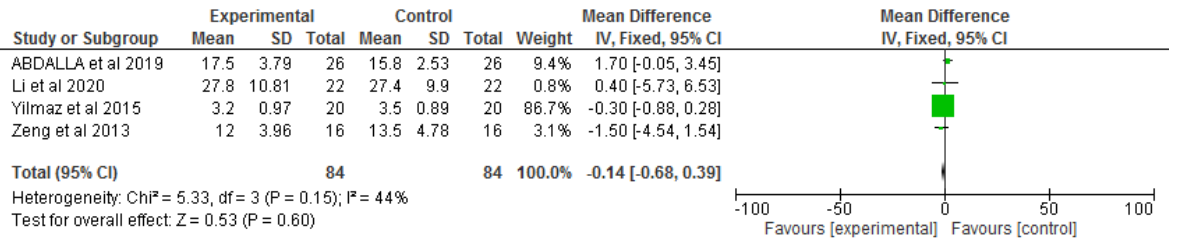
Figure 17. Funnel plot for maxillary expansion between experiment and control after removing the studies lies outside the funnel. 4. Discussion Respiratory function has a considerable influence on the development of the cranio- facial complex, and the upper airway assessment has been an important concern for the orthodontist while performing different modalities of the management of dental and skel- etal malocclusion [2]. Controversies exist regarding the influence of orthodontic treatment on the upper airway; hence we undertook this systematic review. Twenty-seven studies were found to be appropriate for inclusion in this review, and the methodological quality of most of the studies was acceptable which permitted quantitative synthesis. The effects on the airway were assessed with orthopaedic protraction, rapid maxillary expansion, myofunctional appliances, fixed orthodontic therapy with extraction, and orthognathic surgery for correction of skeletal Class II and Class III malocclusion. Randomised controlled trials provide the highest level of evidence. However, well- conducted observational studies also contribute meaningful evidence to the existing sci- entific knowledge, especially when randomised clinical trials are unethical or unfeasible [16]. Because there were not enough randomised studies that evaluated the airway after different modalities of orthodontic treatment, prospective, and retrospective observa- tional studies were also included in this review. Airway dimensions are assessed by various means including lateral cephalograms, and CBCT. Although the pharyngeal airway is a 3-D structure. Conventional lateral